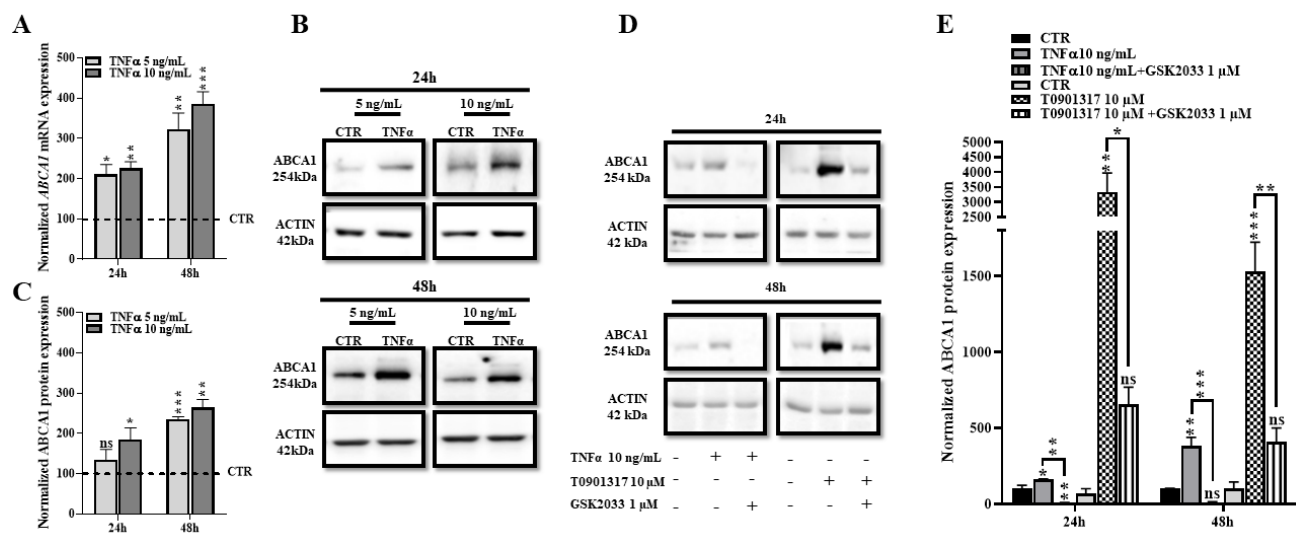
Figure 4. TNF α treatment increases ABCA1 mRNA and protein expression and LXR inhibition allevi- ates TNF α -mediated ABCA1 expression. ( A ). Transcriptional expression of ABCA1 was measured by RT-qPCR. Each bar represents the level of mRNA expression normalized to the housekeeping gene GAPDH , relative to the control condition (CTR). Data are shown as the mean ± SEM of three experiments from pooled triplicates (N = 3). Statistical analysis: Student’s t -test, ns: non-significant, * p < 0.05, ** p < 0.01, *** p < 0.001. ( B ). ABCA1 protein level was assessed by Western blot. ( C ). Each bar represents the level of quantified ABCA1 signal normalized to ACTIN, relative to the CTR condition. Data are shown as the mean ± SEM of three independent experiments (N = 3). Statistical analysis: Student’s t -test, ns: non-significant ** p < 0.01, *** p < 0.001. ( D ). To inhibit LXR activation, HBP were pre-treated for 30 min with GSK2033 (1 µ M) then incubated with T0901317 (10 µ M) or with TNF α (10 ng/mL) for 24 and 48 h. ( E ). Each bar represents ABCA1 protein expression normalized to ACTIN, relative to the control condition (CTR). Data are shown as the mean ± SEM of three independent experiments (N = 3). Statistical analysis: one- way ANOVA followed by Tukey’s mul-